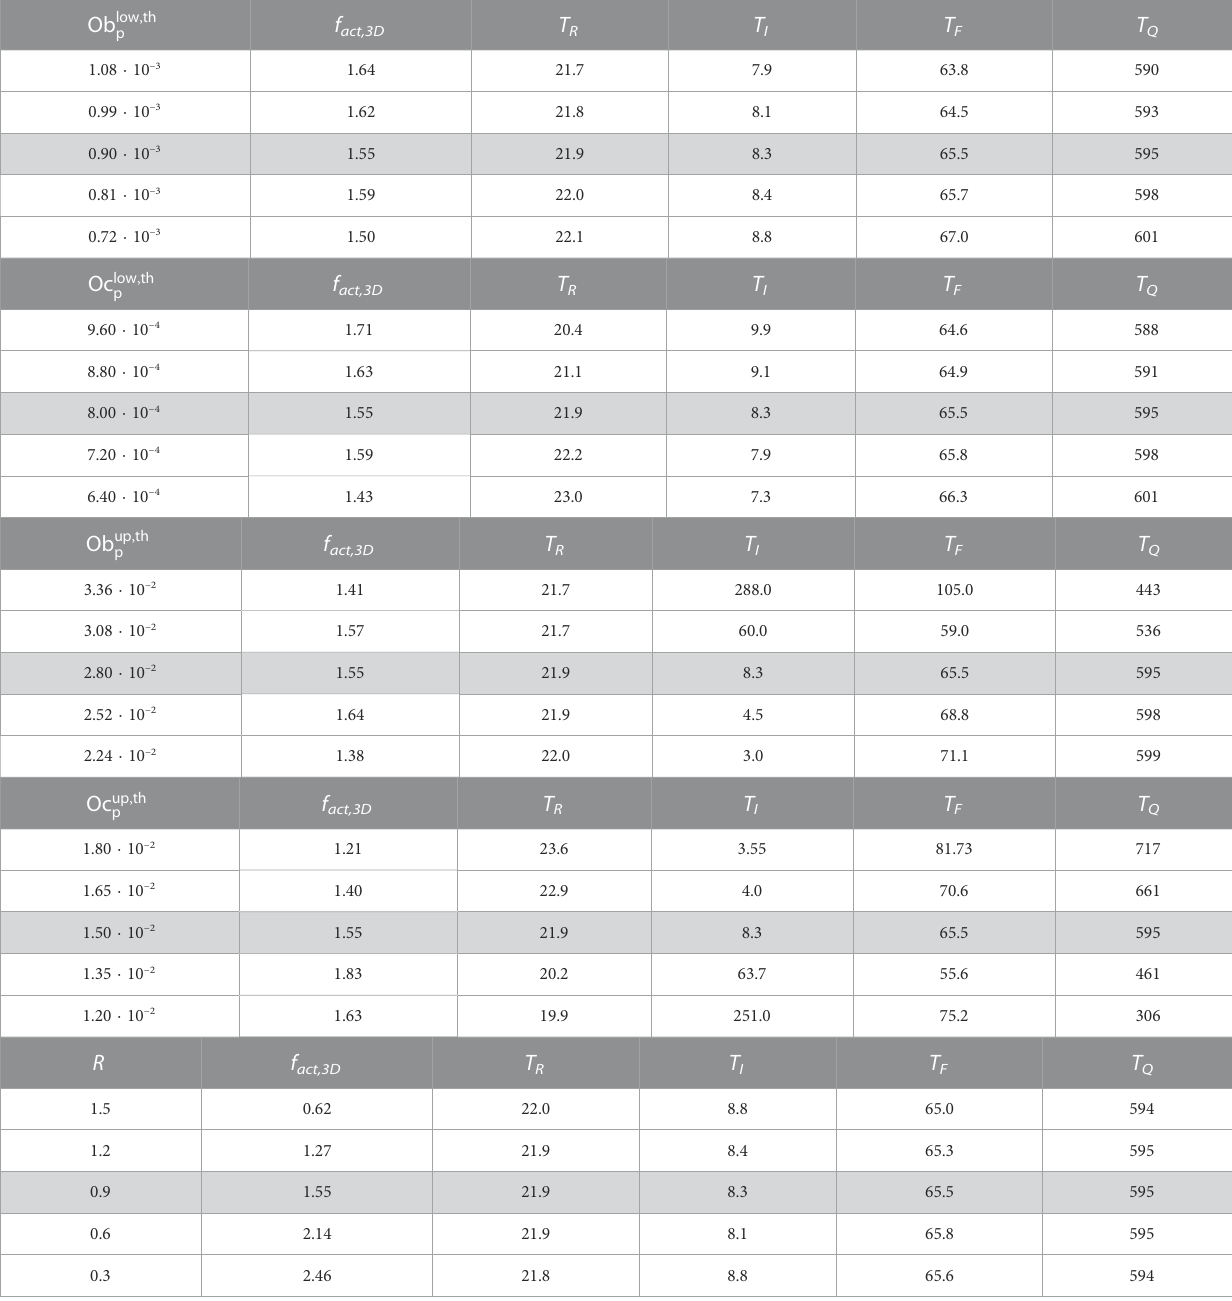
TABLE 3 Sensitivity analysis of Ob low , th p , Oc low , th p , Ob up , th p , Oc up , th p and R . Ob low , th